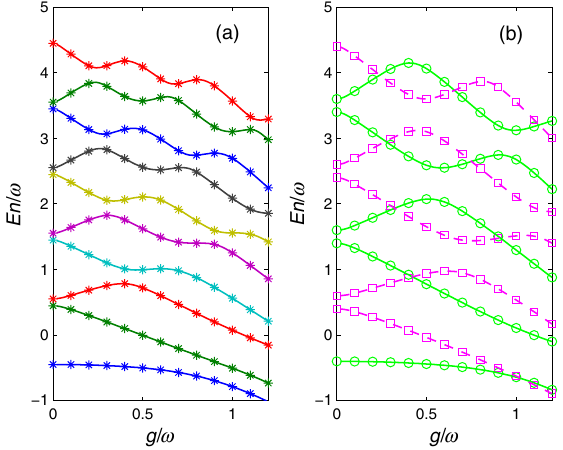
FIG. 3. Comparison between the exact solution and the numerical results. (a) Energy spectrum for ω ¼ 1 , Δ ¼ 0 . 4 , λ ¼ 0 . 5 , ϵ ¼ 0 . 2 , and θ ¼ − π = 2 . Solid lines are exact results, and the energy levels are differentiated by colors. Numerical results are represented by stars. (b) Energy spectrum for ω ¼ 1 , Δ ¼ 0 . 4 , λ ¼ 0 . 5 , ϵ ¼ 0 , and θ ¼ 0 in the spaces with positive (green lines with circles) and negative (purple lines with squares) parities. Small squares and circles represent numerical results. The first energy-level-crossing point is at g and E ¼ − 2 = 3 , which has no definite